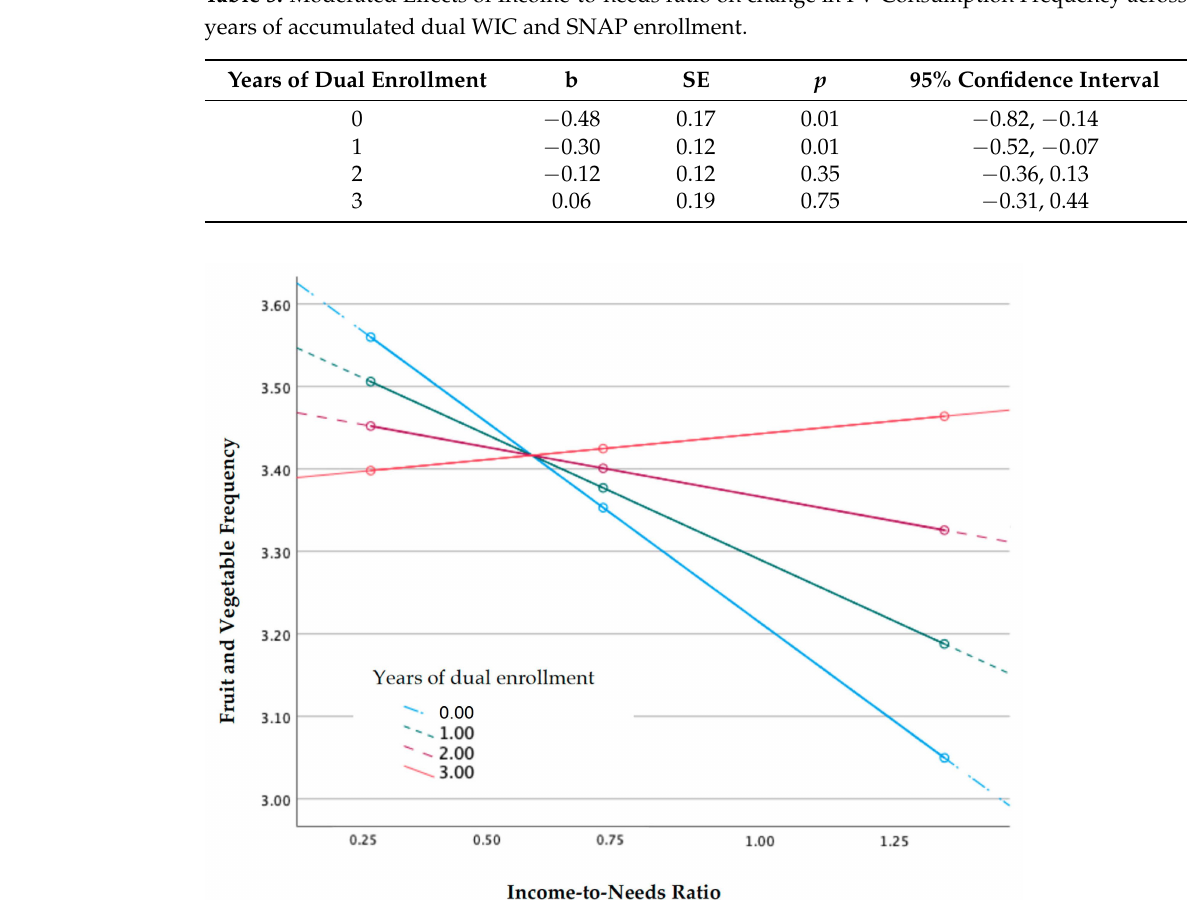
Figure 1. Moderated effects of Accumulated Dual WIC and SNAP Enrollment on change in FV Consumption Frequency across levels of INR from child ages 5 to 9